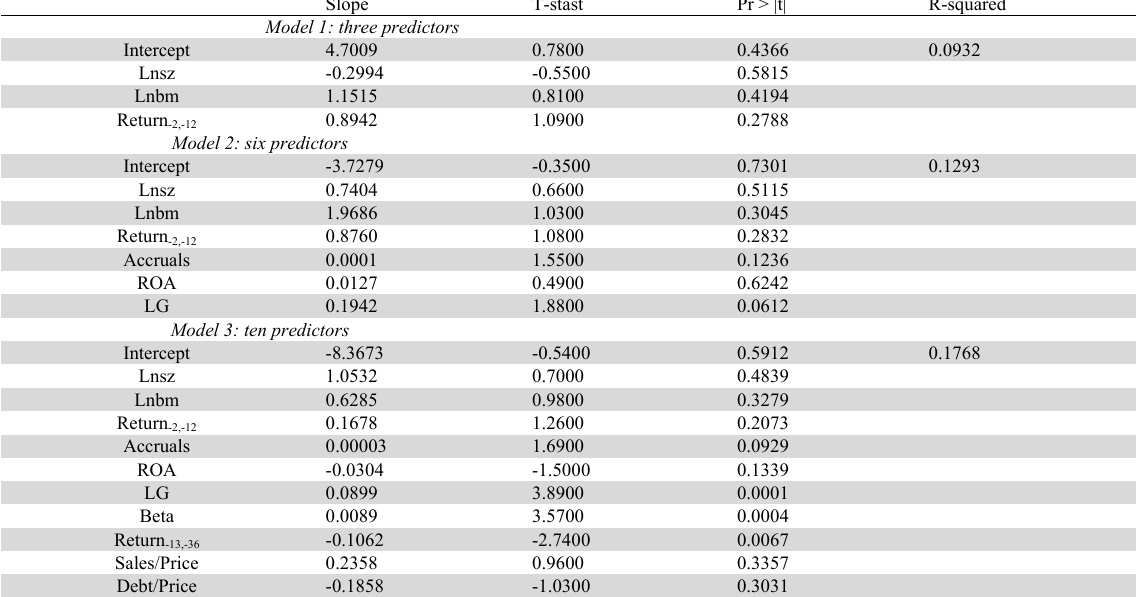
Slope T-stast Pr > |t| R-squared Model 1: three